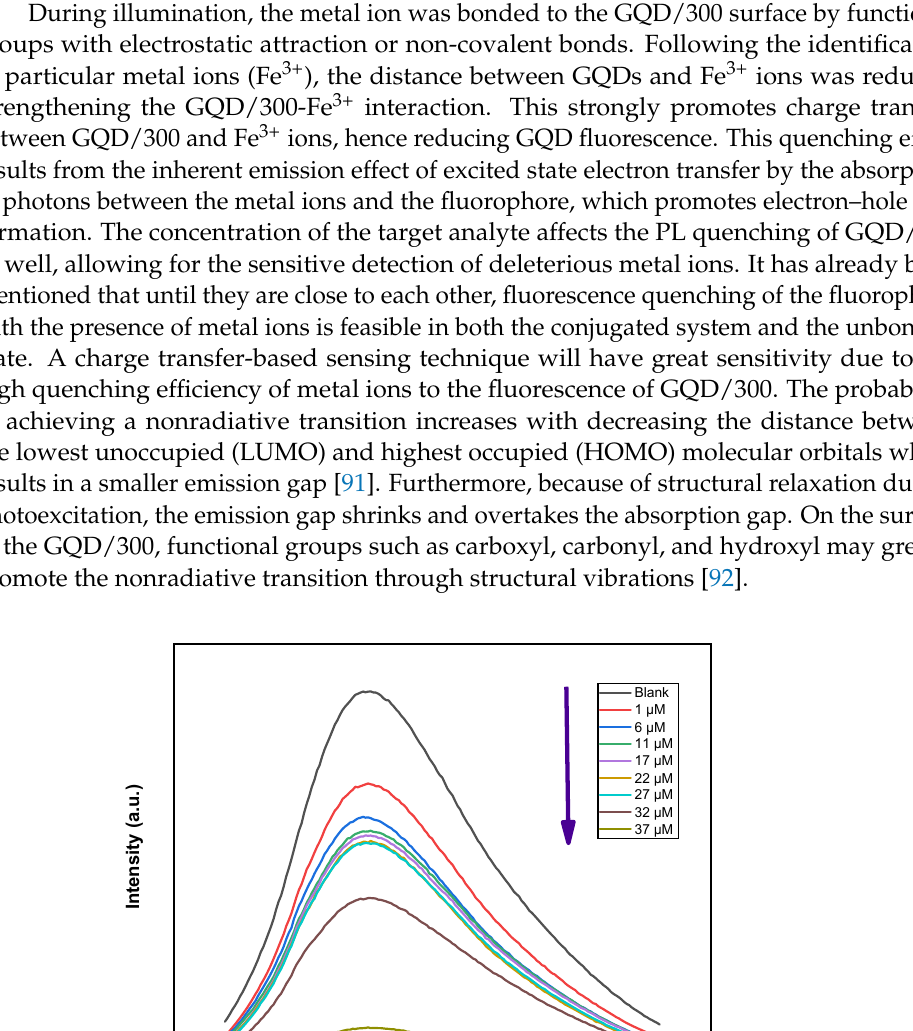
Figure 4 ( a ) TEM images of GQD/300 at 10 nm magnification ( b ) TEM images of GQD/300 at 5 nm magnification ( c ) particle size distribution of GQD/300 ( d ) XRD spectrum of GQD/300 ( e ) FTIR spec- trum of GQD/300 ( f ) Raman spectrum of GQD/300.